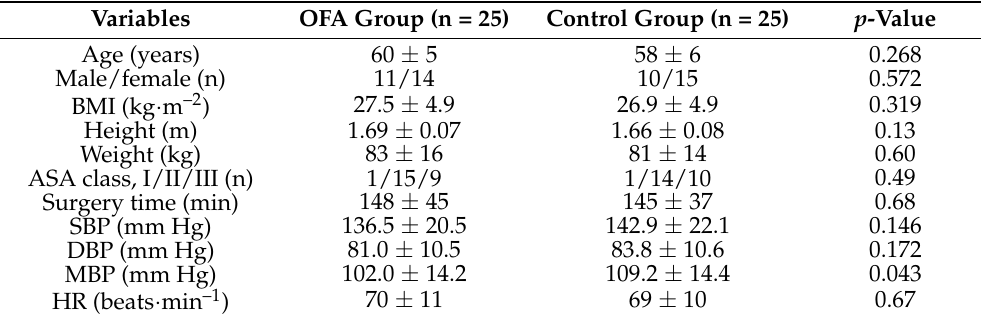
Table 1. Demographic and main patient